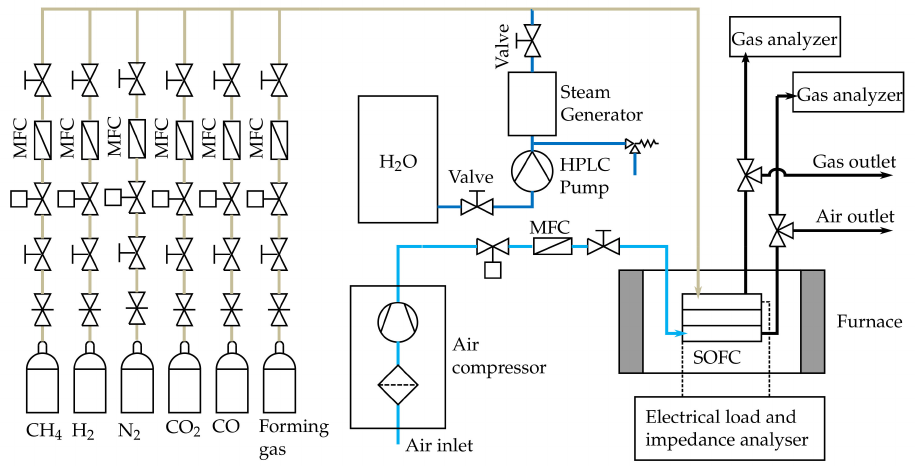
Figure 6. Scheme of the SOFC test